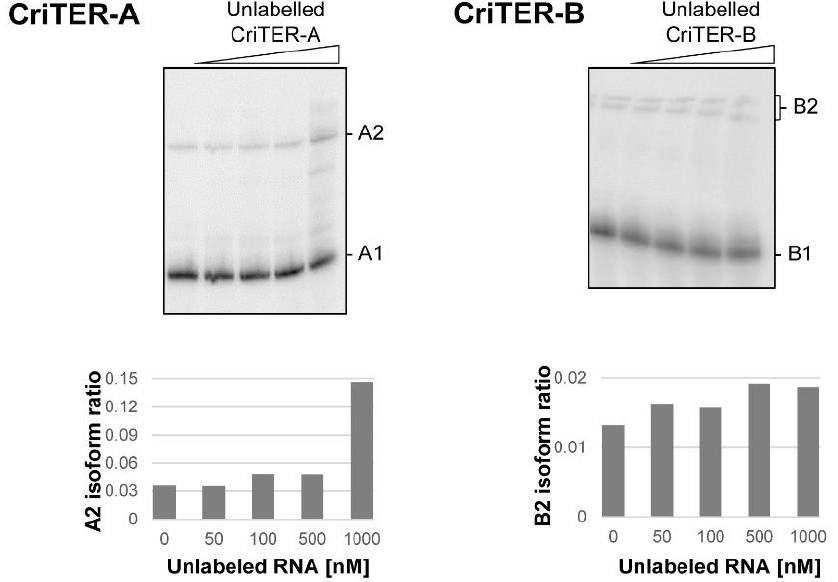
Figure 5. CriTER-A and CriTER-B telomeric RNAs do not dimerize. Autoradiography of native polyacrylamide gels of 32 P-internally labelled CriTER-A and CriTER-B transcripts in the presence of increasing concentrations of the respective unlabelled RNAs. Assays were performed at basal temperature (20 ◦ C) in the absence of Mg 2+ . A quantification of the representative gels is shown at the bottom of each panel. A1 and A2 indicate the two conformers of the CriTER-A RNA. B1 and B2 denote the two conformers of the CriTER-B RNA.